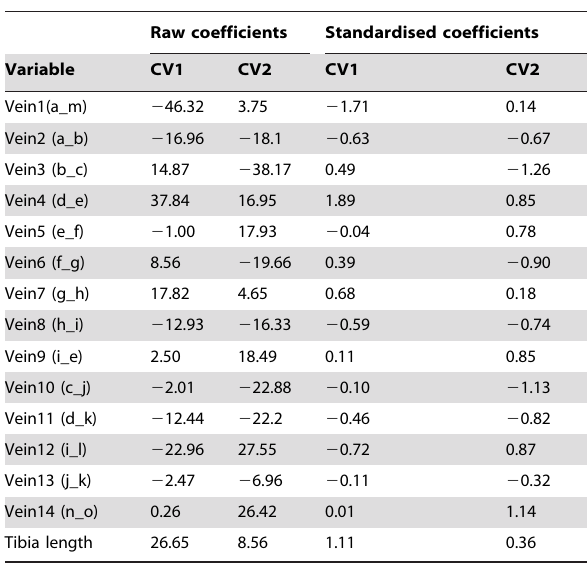
Table 2. Raw and standardized canonical coefficients for the canonical discriminant analysis on log-transformed wing measurements data for the fruit fly populations.